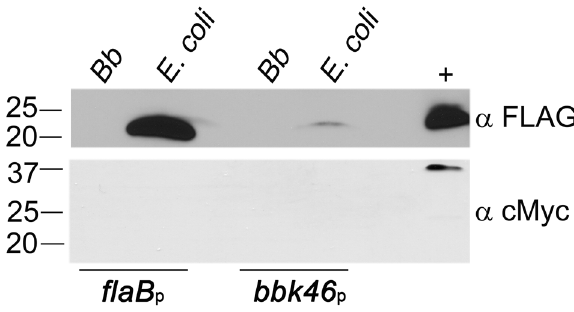
Figure 6. BBK46 protein production is detectable in E.coli but not in B. burgdorferi . Immunoblot analysis of total protein lysate prepared from 1.5 6 10 8 B. burgdorferi D bbk46 ( Bb ) or E. coli harboring either pBSV2G flaB p - bbk46 - FLAG - cMyc ( flaB p ) or pBSV2G bbk46 p - bbk46 - FLAG - cMyc ( bbk46 p ). Protein lysates were separated by SDS-PAGE and immunoblots performed using anti-FLAG monoclonal antibodies ( a FLAG) and anti-cMyc monoclonal antibodies ( a cMyc). 300 ng of purified PncA-FLAG [23] and GST-BmpA-cMyc [78] proteins served as positive controls ( + ) for each antibody. The positions of markers to the left of the panel depict protein standard molecular masses in kilodaltons.